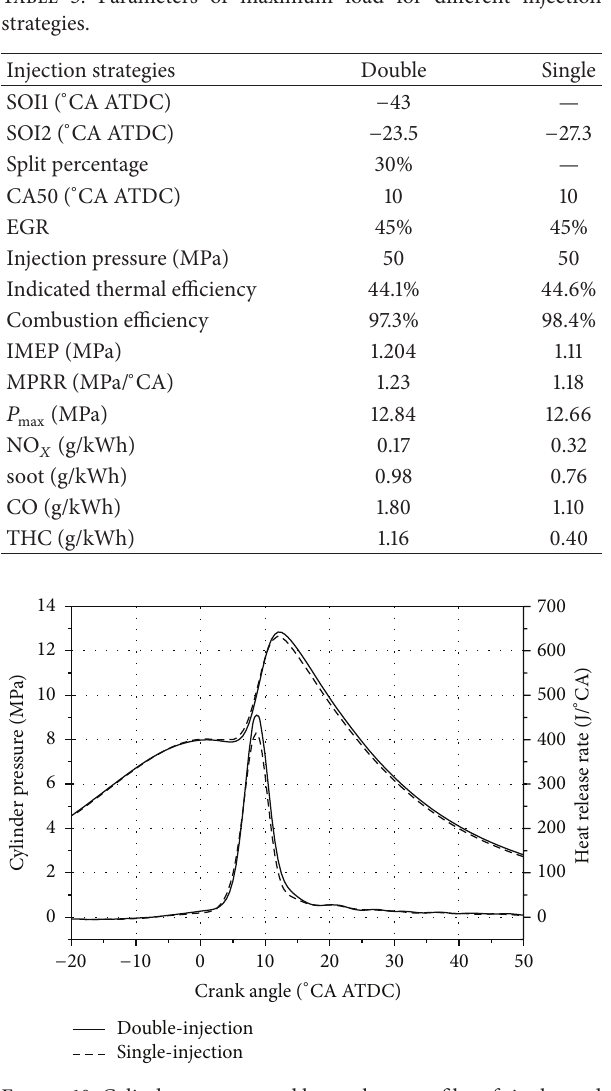
Figure 10: Cylinder pressure and heat release profiles of single- and double-injection